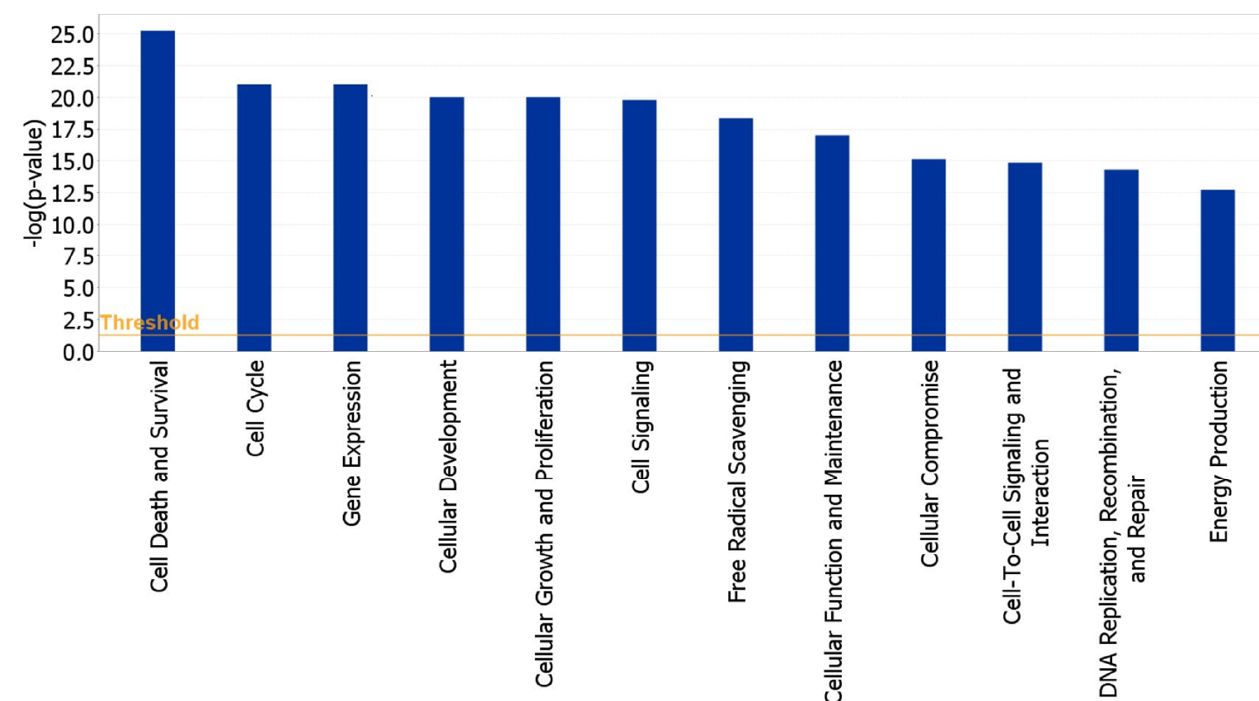
Figure 3 . Ingenuity pathway analysis (IPA)-generated bar-chart indicating the main significant biological functions regulated by our gene dataset in cumulus cells.